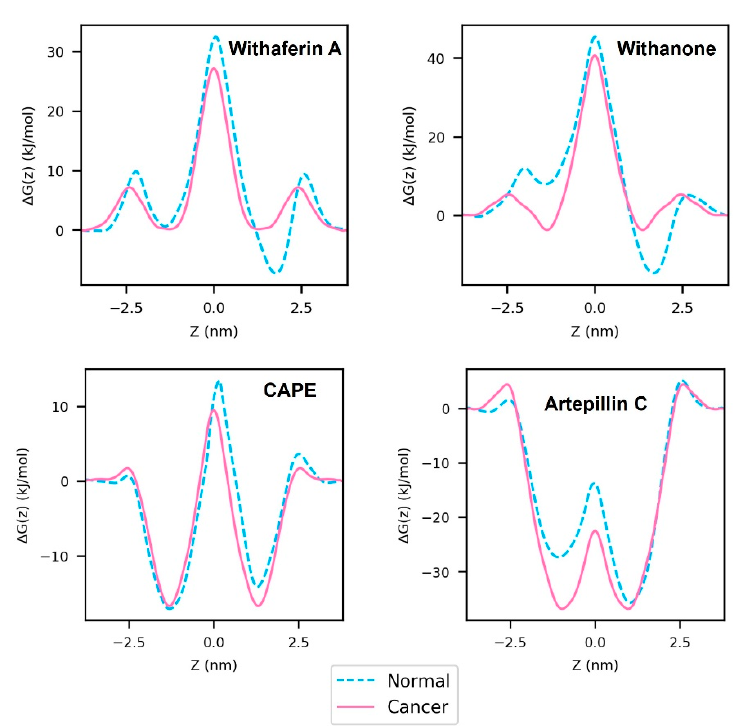
Figure 6. PMF profiles of Withaferin A (Wi ‐ A), Withanone (Wi ‐ N), Caffeic Acid Phenethyl Ester (CAPE) and Artepillin C (ARC). The solid magenta line indicates the PMF profile in the cancer cell membrane model and the dashed cyan line indicates the PMF profile in the normal cell membrane model. On the horizontal axis, the value 0 indicates the center of the hydrophobic core of the membrane, negative values indicate the outer (extracellular) leaflet and positive values indicate the inner (cytoplasmic) leaflet.